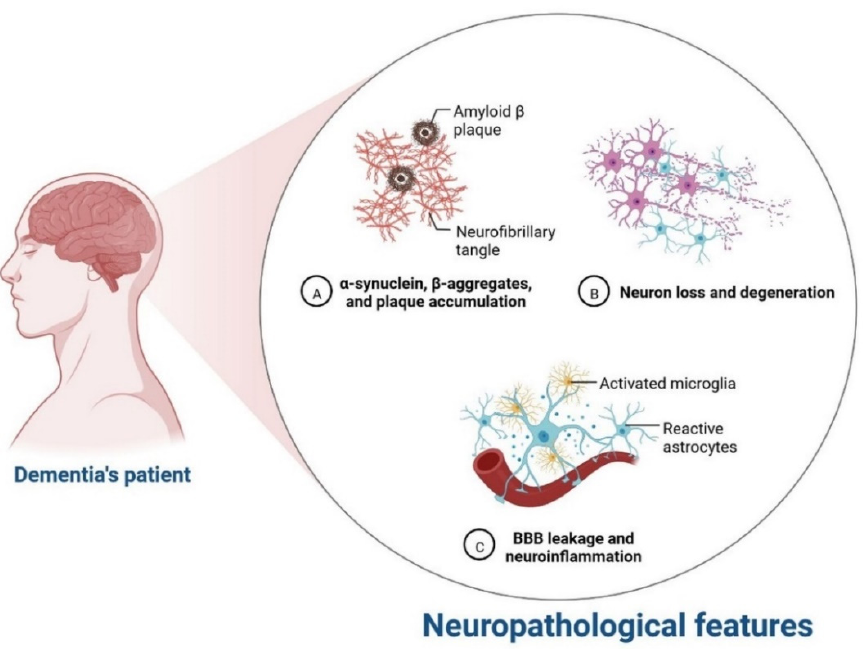
Figure 10. Neurological complication in dementia patients.